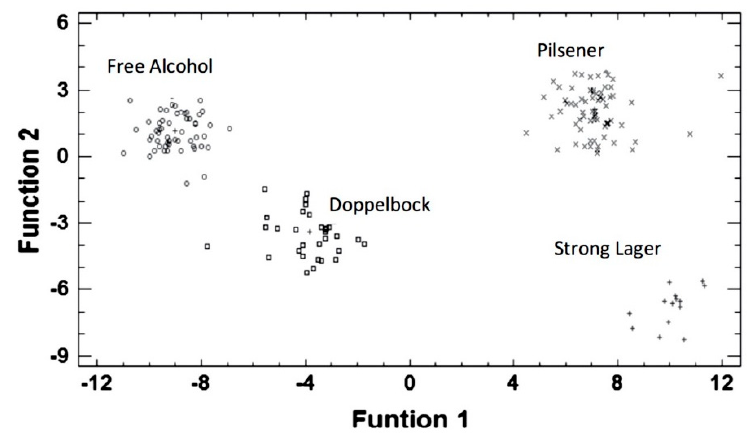
Figure 5. Scores plot obtained in the LDA treatment of CV data (see Figure 4) acquired with four commercial screen-printed sensors in beer belonging to three different categories. Reproduced from [48] with permission.